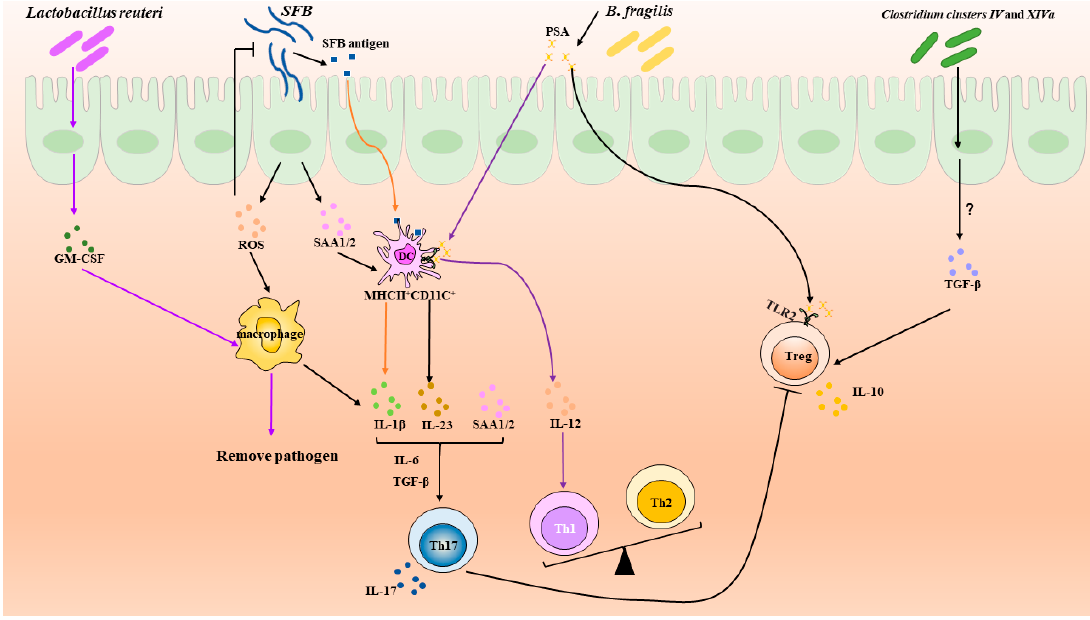
Figure 1. Roles of the microbiota in the balance of Th17 and Treg.